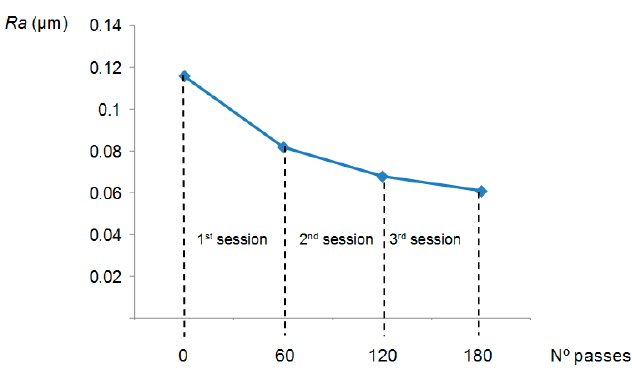
Figure 2. Ra versus polishing passes obtained at the end of each polishing session.